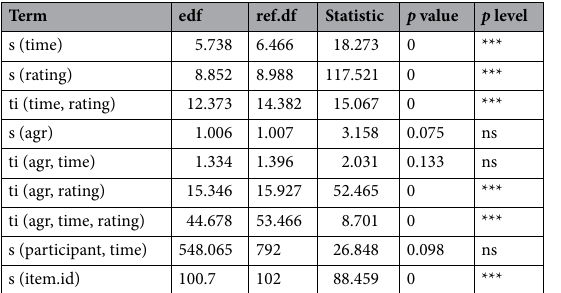
Table 6. Summary output for the GAMM modelling participants’ pupil sizes in response to semantic anomalies and with their Agreeableness score as a predictor.